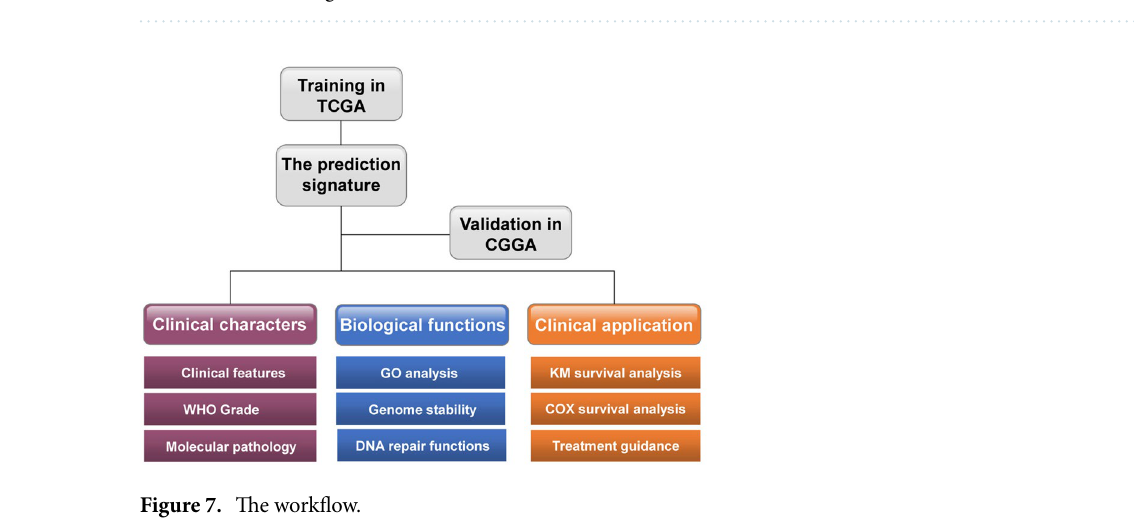
Figure 6. ROC curves showed the predictive efficiency of the signature and the 5 probes respectively on 1,2,3,4 and 5 years of OS or PFS in TCGA and CGGA databases. (The curve of GNMT was covered by the curve of RCSD1 for coinciding in CGGA database) (A-T).